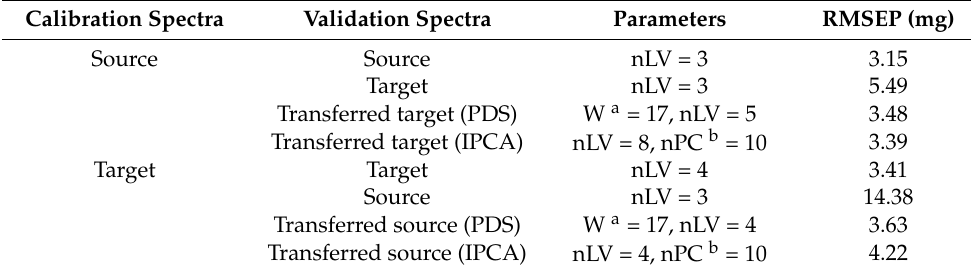
Table 1. Calibration transfer results obtained by PDS and IPCA for dataset 1. Calibration Spectra Validation